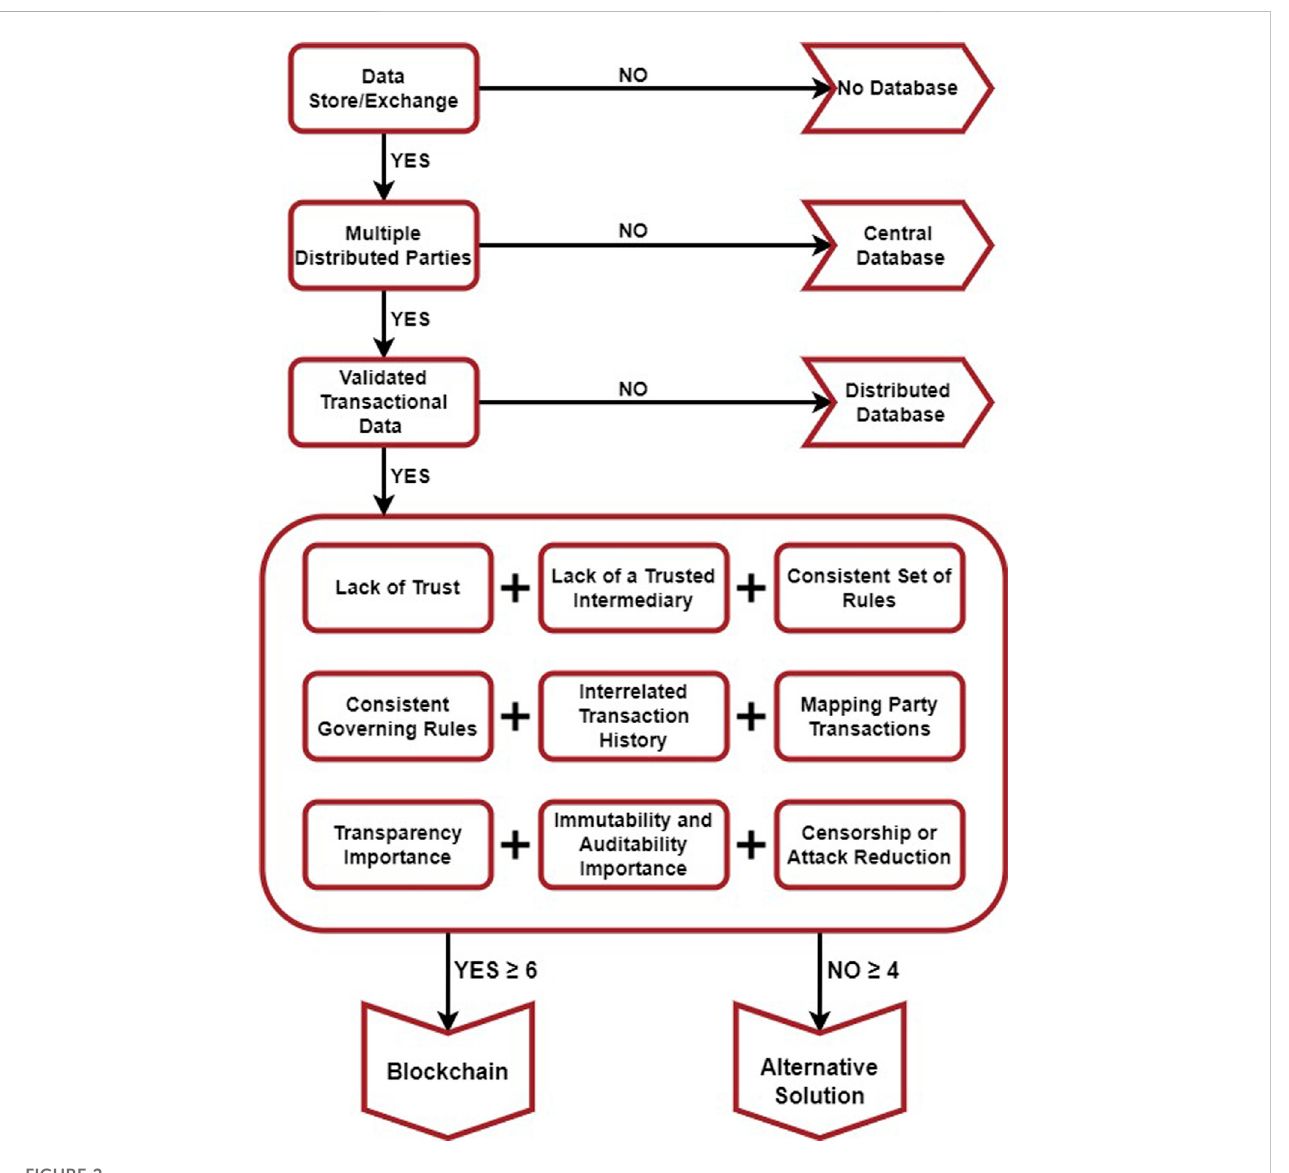
FIGURE 2 Blockchain Critical Assessment